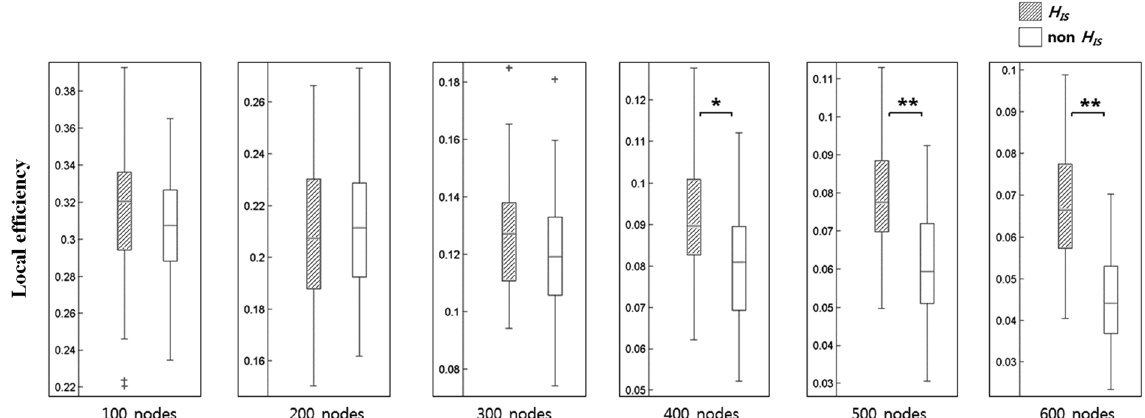
Figure 3. Validation of scale-integrated hub ( H IS ). The H IS regions had a tendency of increasing contributions to local efficiency than the non H IS regions at most scales. The error bars represented the standard deviation. Note that ** and * designated statistically significant differences with p < 0.001 and p < 0.05, respectively.